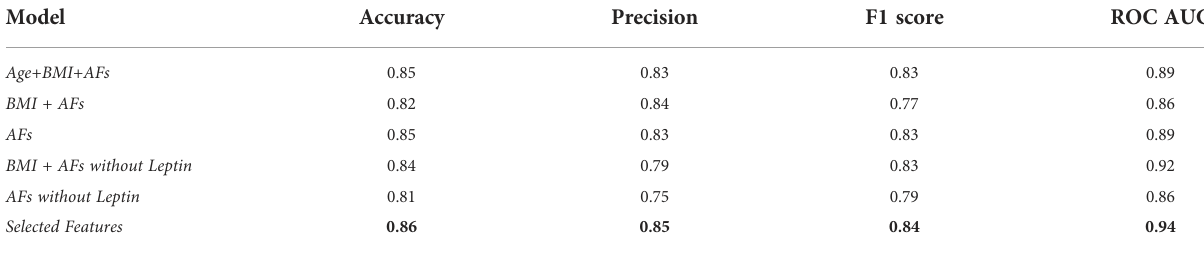
TABLE 5 Performance metrics of multivariate models based on multiple features on training data.